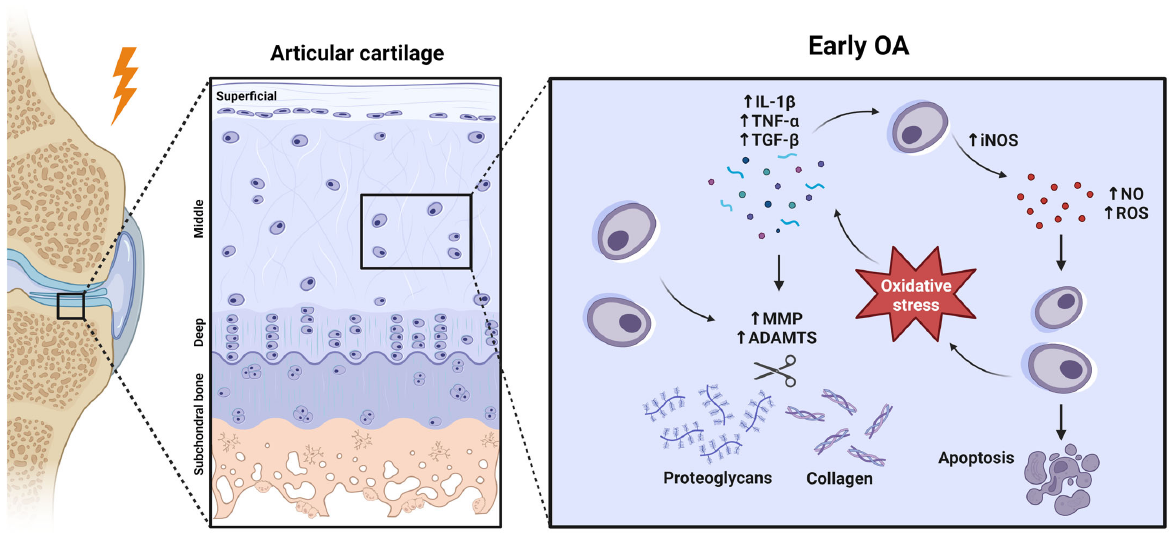
Figure 1. Early OA development at a molecular perspective. Created with BioRender.com, accessed on 14 January 2023.